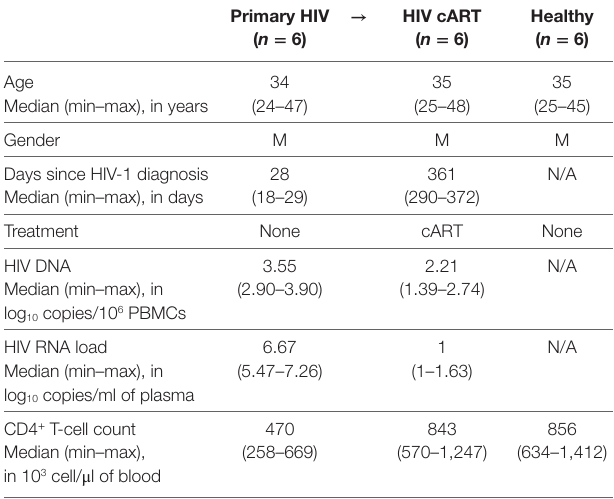
TaBle 1 | Summary of patient and subject clinical